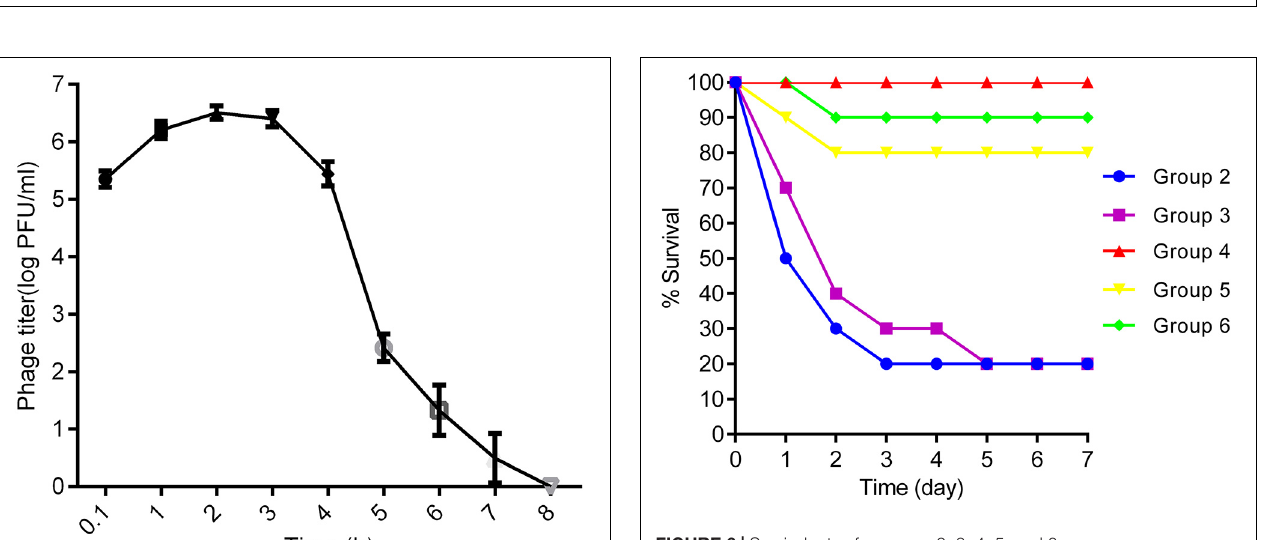
kpssk3 very applicable for treatment of systemic infections. However, the maximum phage concentration in the blood was approximately 100-fold lower than the injected phage concentration, and no phage was detected in the blood only 8 h after intraperitoneal delivery. Phage kpssk3 was expected to be diluted in blood and cleared by the mononuclear